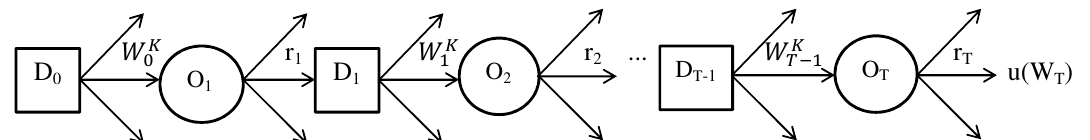
Figure 9. Decision tree for the multi-period portfolio selection